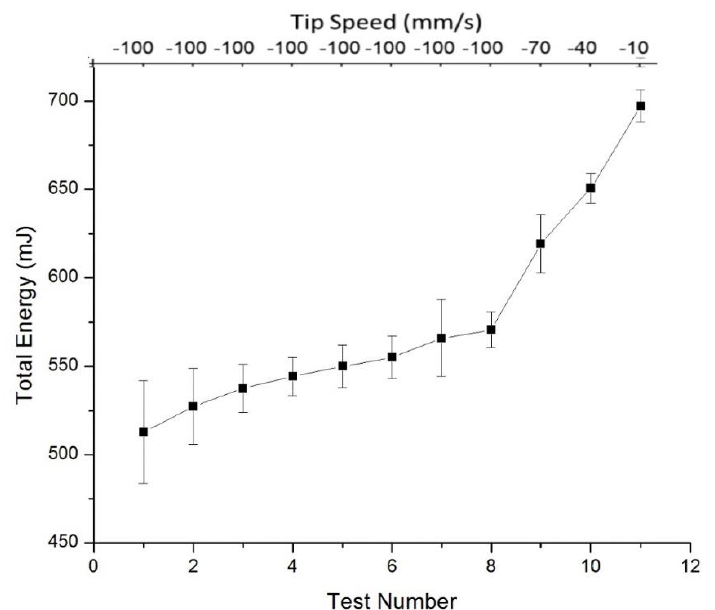
Figure 3. The results of eleven Variable Flow Rate (VFR) and Stability fluidity tests for Powder A are shown with the total energy noted versus the test number and tip speed. The negative sign for tip speed is a convention denoted tip direction. Three separate, random test samples of Powder A were analysed. The three runs were averaged and 95% CI bars are shown.